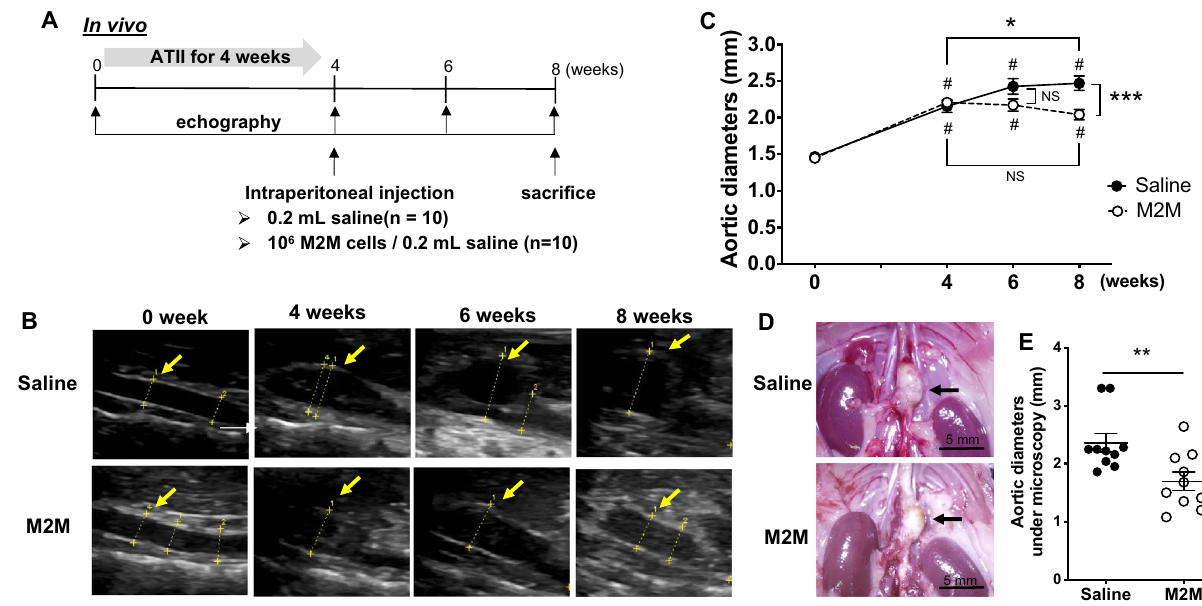
Figure 1. Diagram of study protocols ( A ). After ATII was administered to apoE −/− mice for 4 weeks, 1 × 10 6 M2M cells or saline was injected intraperitoneally (n = 10 mice, respectively). Mice underwent echography at 0, 4, 6 and 8 weeks, and were sacrificed at 8 weeks. ( B ) Representative long-axis echography images of the thoracoabdominal aorta. ( C ) Aortic diameters measured by echography (n = 10 mice per group). Data are means ± SEM. * p < 0.05 versus time of injection (week 4) within group. # p < 0.05 versus just before ATII infusion (week 0) within group. *** p < 0.001 between groups at 8 weeks. Data assessed by two-way repeated measures ANOVA followed by Tukey’s multiple comparisons test. ( D ) Representative AA images obtained by microscopy (black arrows). Scale bars = 5 mm. ( E ) Aortic diameters measured by microscopy (n = 10 mice per group) Data are means ± SEM. ** p < 0.01 assessed by the Mann–Whitney U test. ATII: angiotensin II, apoE −/− : apolipoprotein E deficient, M2M: M2 macrophage, NS: not